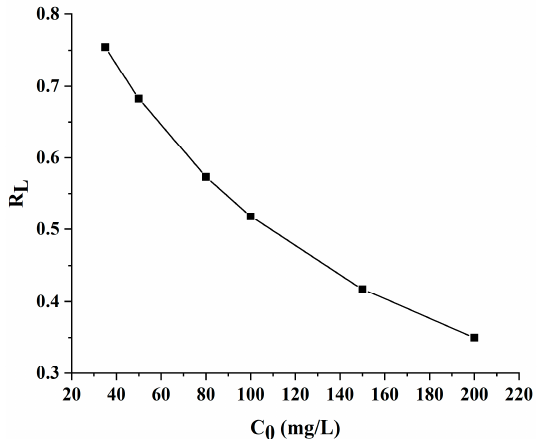
Figure 8. Separation factor R L for the adsorption of AlgL on BC.